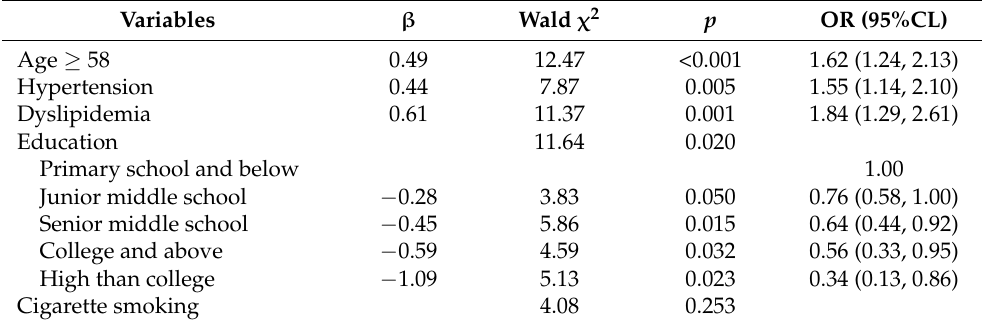
Table 4. Logistic regression showing predictors of normal weight central obesity in